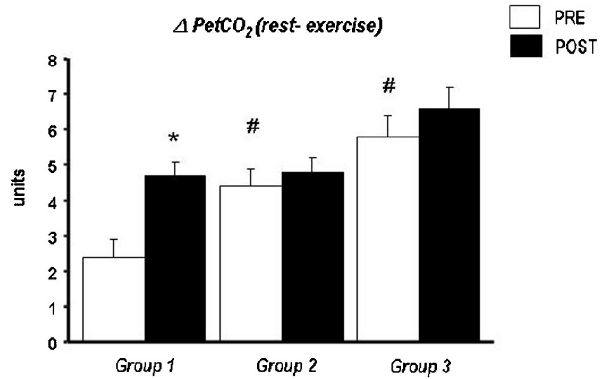
Figure 2 - The change in PeTCO 2 from rest to the highest value during exercise in CAD patients who underwent aerobic exercise training; * p , 0.05 pre-intervention; # p , 0.05 vs . group